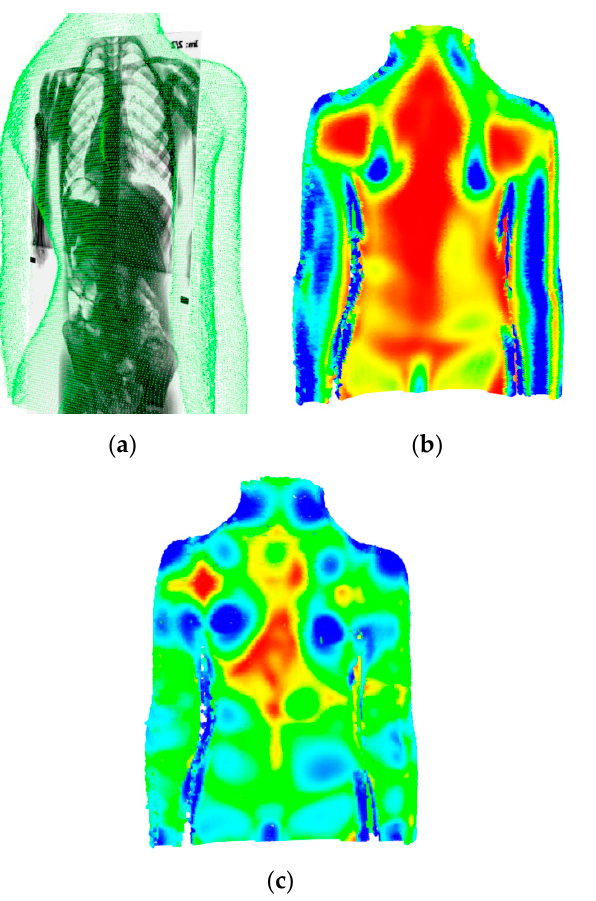
Figure 4. Visualization of data obtained from the 3D ST scanning system. The composition of a cloud of points with a radiogram image ( a ). Gaussian curvature ( b ) and mean curvature ( c ) calculated for the cloud of points.